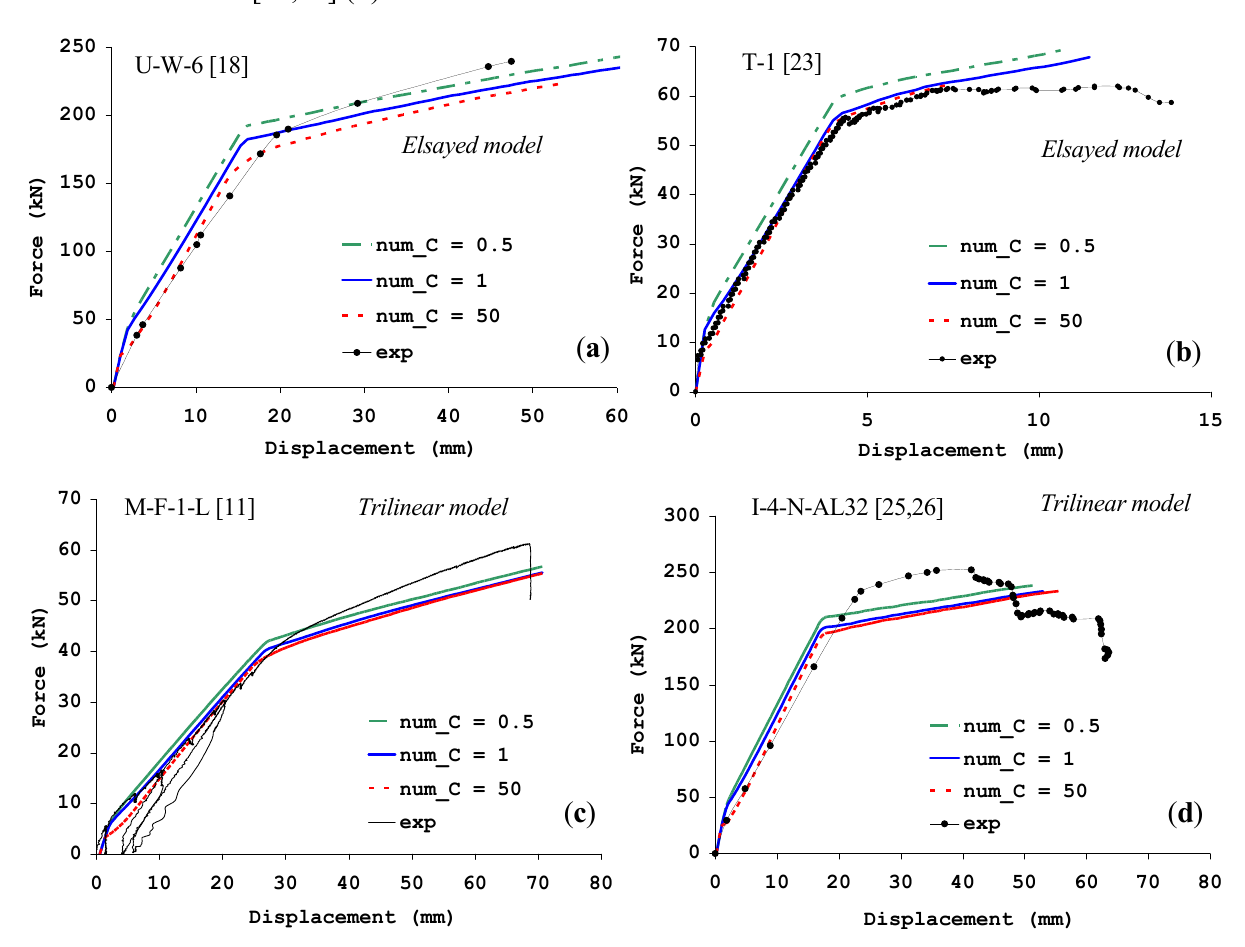
Figure 10. Influence of the tension-stiffening effect: numerical simulations of tests by Borowicz [18] ( a ); Lamanna [23] ( b ); Napoli et al . [11] ( c ); Bank et al . and Lamanna et al. [25,26] ( d